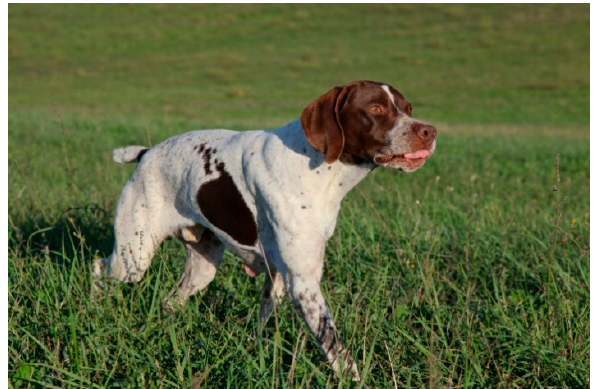
Figure 1. Example of Braque Français, type Pyrénées breed.